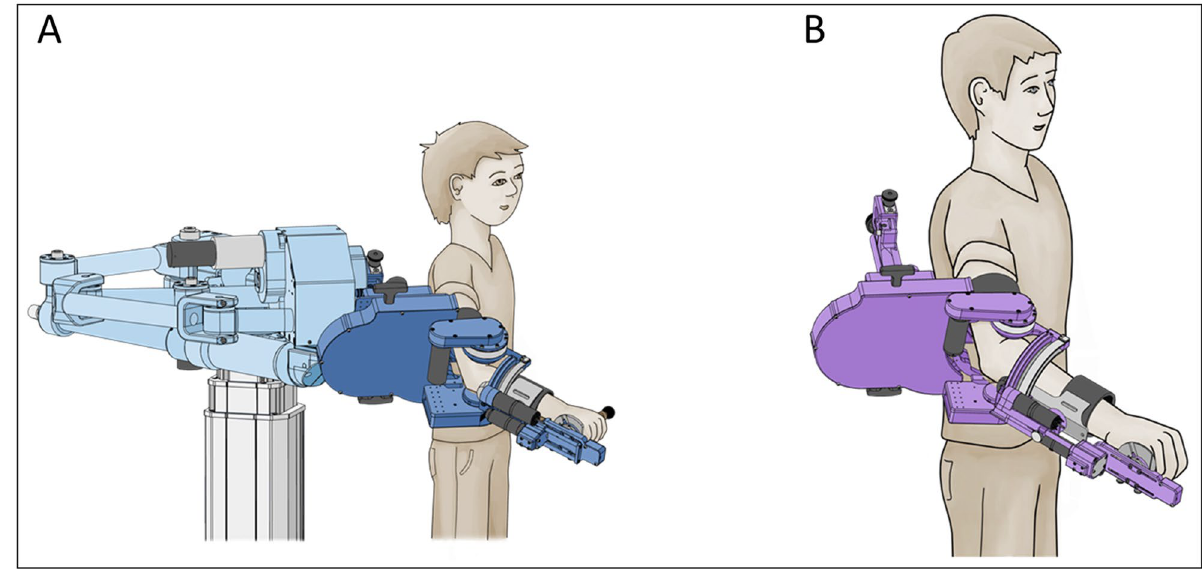
Figure 1. Schematic picture of the ChARMin robot. ( A ) The small distale module ( B ) The large distal module. Courtesy of Susanne Staubli and Urs